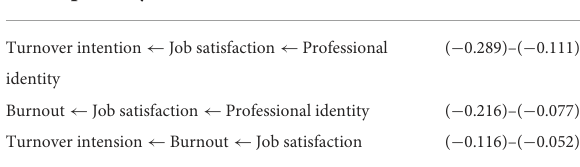
TABLE 7 Significance test of every mediating